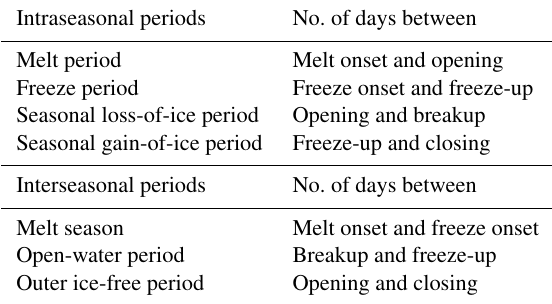
Table 2. Definitions of the periods of time between the seasonal transition dates, including shorter, intraseasonal periods of transi- tion as well as longer, interseasonal periods. The outer ice-free pe- riod and the seasonal loss-of-ice and gain-of-ice periods were de- fined in Steele et al.